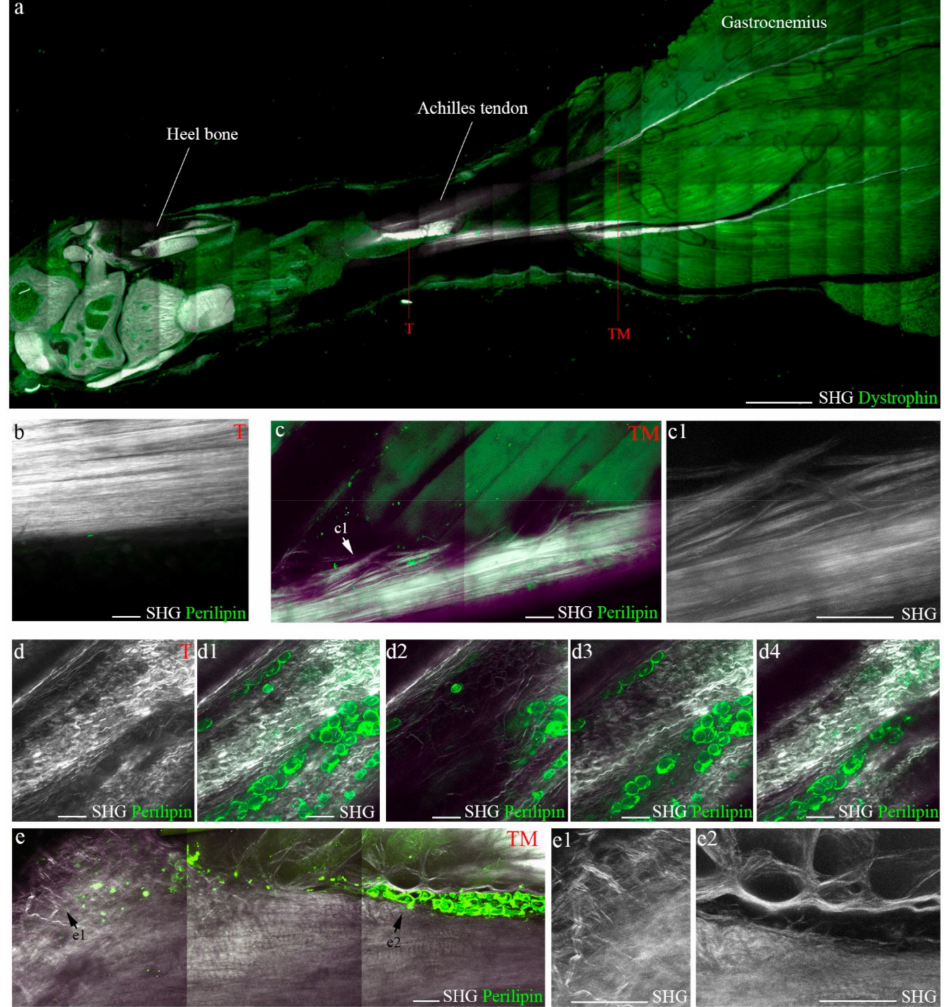
Figure 6. SHG signals monitor damage after Achilles tendon complete rupture. ( a ) Representa- tive multiphoton image of the heel bone-Achilles-gastrocnemius unit combined with dystrophin immunostaining, highlighting areas in the tendon itself (T) and at the tendon-muscle connection (TM). Scale bar 1 mm. Representative images of SHG-perilipin immunostaining in ( b – c1 ) healthy and ( d – e2 ) injured tissues. ( c1 , d1 – d4 , e1 , e2 ) are high magnification images of ( c – e ) pictures. Scale bar 50 µ m. SHG, second-harmonic